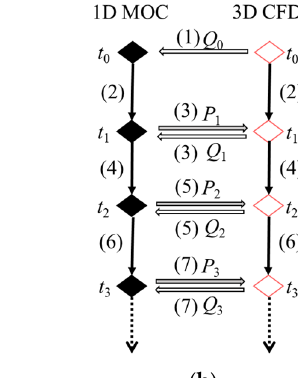
Figure 4. Interface of the coupling algorithm with overlapping meshes.